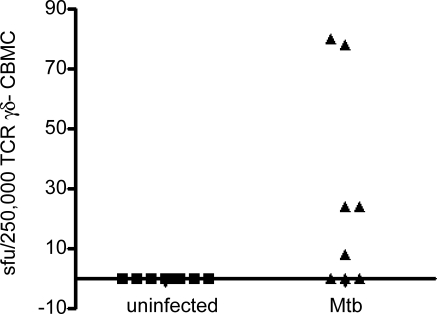
Mtb-Reactive Cells Are Present in Cord BloodCord blood mononuclear cells (250,000 cells/well) were depleted of γδTCR+ cells using magnetic bead separation. γδTCR–depleted CBMC were incubated with autologous DC (50,000 cells/well) that were either Mtb-infected (moi = 30) of left uninfected. IFN-γ production was tested in an ELISPOT assay (n = 8; range, 0–80 sfu/250,000 γδTCR-depleted CBMC; mean = 26.75 ± SD 33.75).